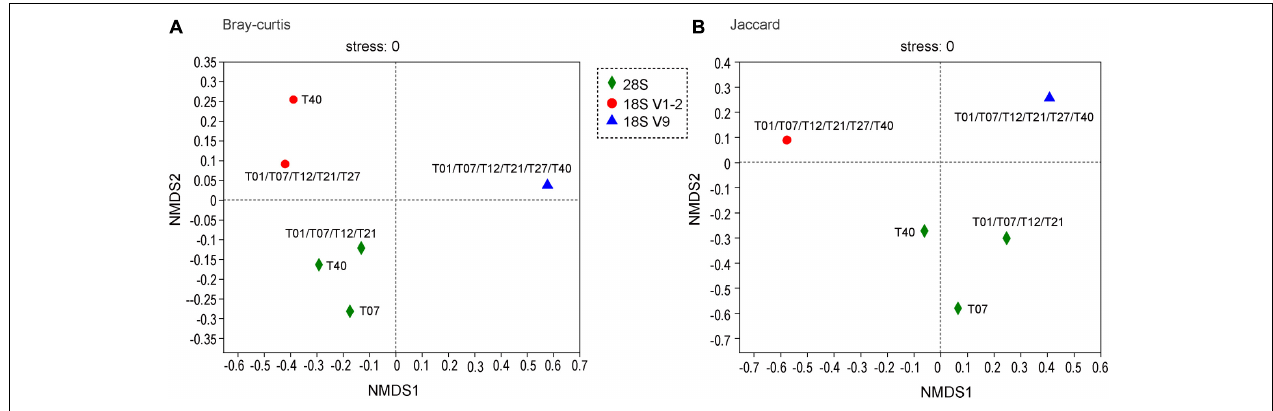
FIGURE 3 | Non-metric multidimensional scaling (NMDS) analysis of benthic community structure (OTU level) detected with 28S, 18S V1-2, and 18S V9 based on abundance (Bray–Curtis) data (A) , and presence/absence (Jaccard) data (B) . Sample names (T01, T07, T12, T21, T27, and T40) are labeled.